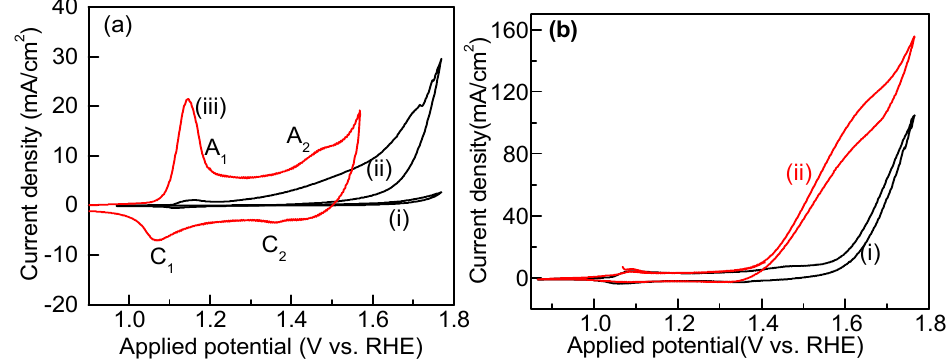
Figure 7. Cyclic voltammograms (CV) of 50 mV/s in 1.0 M KOH solution for 2.1 g/cm 2 for ( a ): blank (i) bulk-Co 3 (PO 4 ) 2 (ii) and Co 3 (PO 4 ) 2 nanospheres (iii) loaded on an Au electrode; ( b ) CVs of Co 3 (PO 4 ) 2 nanosphere-modified electrode at 50 mV/s in 1.0 M KOH for (i) in absence, and (ii) in presence of 1.0 M CH 3 OH.